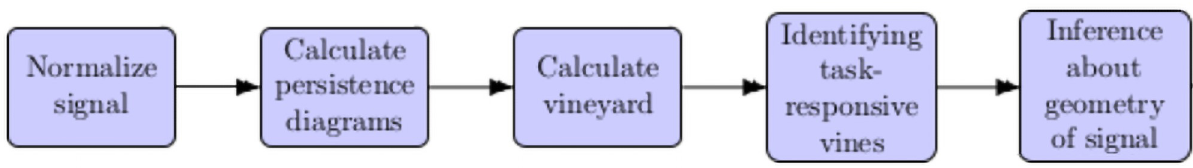
Fig 7. We present our employed workflow used in studying dynamics of persistent homology.